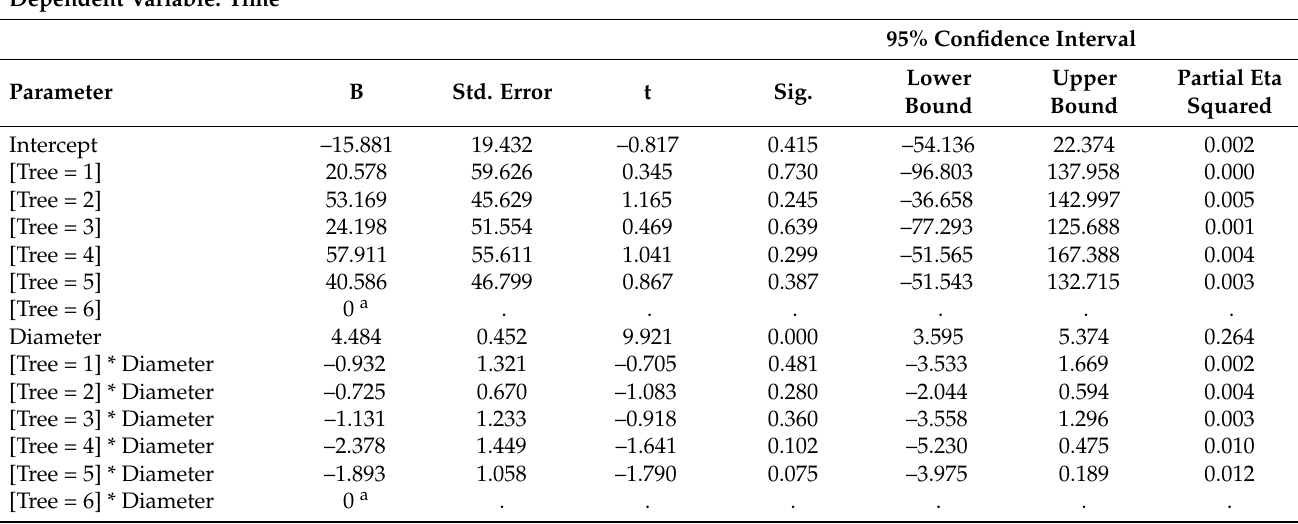
Table 11. Parameter estimates.